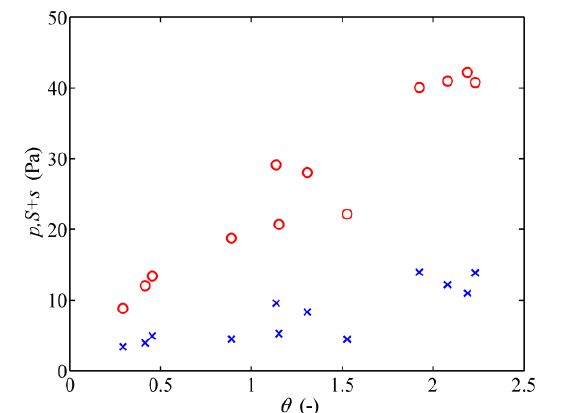
Fig. 6. Local normal granular stress and total shear stress at bottom of collisional part of transport layer related to bed Shields parameter. Legend: circle – total shear stress, cross – normal granular stress.